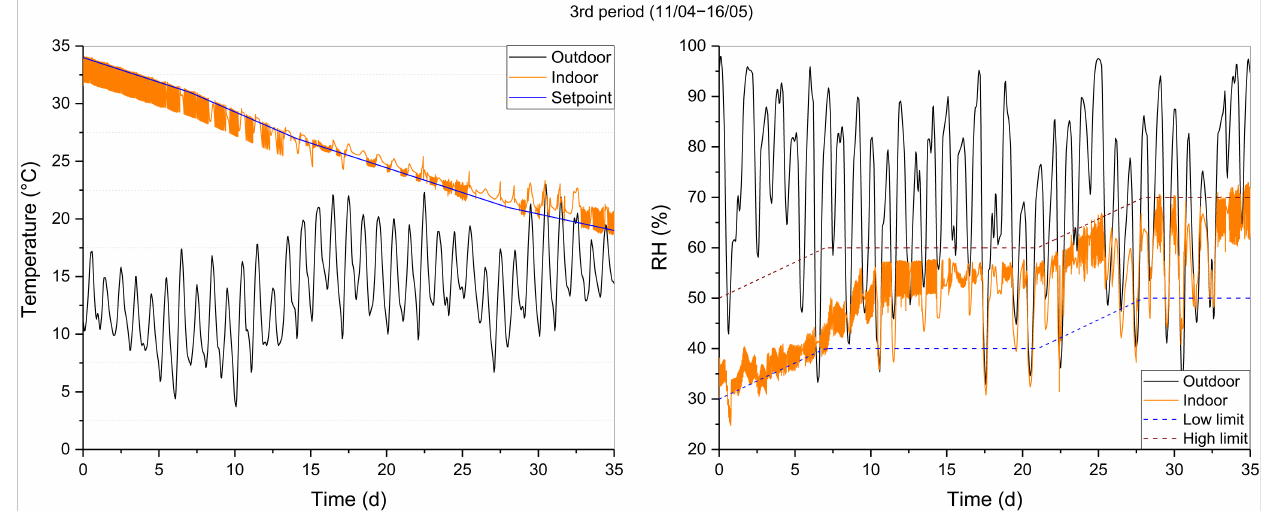
Figure 7. Temperatures and relative humidity variation during the 3rd production period (11.04–16.05). During the 5th PP (20.07–24.08) outdoor temperature ranges from 18.8 to 34.2 ◦ C (avg. 25.6 ◦ C) and relative humidity from 19.6 to 80.4% (avg. 51.8%). Indoor conditions exhibit a behavior similar to the 4th PP, with temperature deviating between − 2.3 and +5.7 ◦ C, and relative humidity between − 5.9 and +1.5% (Figure 9). In the course of the 6th PP (08.09–13.10), outdoor temperature ranges from 18.8 to 34.2 ◦ C (avg. 25.6 ◦ C) and relative humidity from 19.6 to 80.4% (avg. 51.8%). Even though the indoor temperature profile follows a pattern similar to PP5, with maximum deviations of − 2.3 and +3.1 ◦ C, the deviations from the acceptable range in the case of humidity are greater (Figure 10). A − 18.1% deviation was observed twice during the first 6